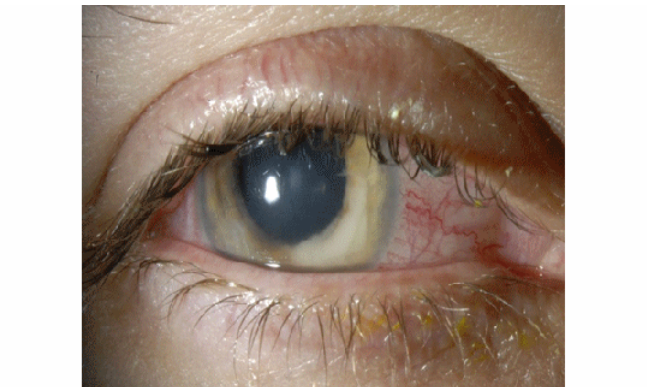
Figure 2: Examination following first anterior chamber lavage (day 3)